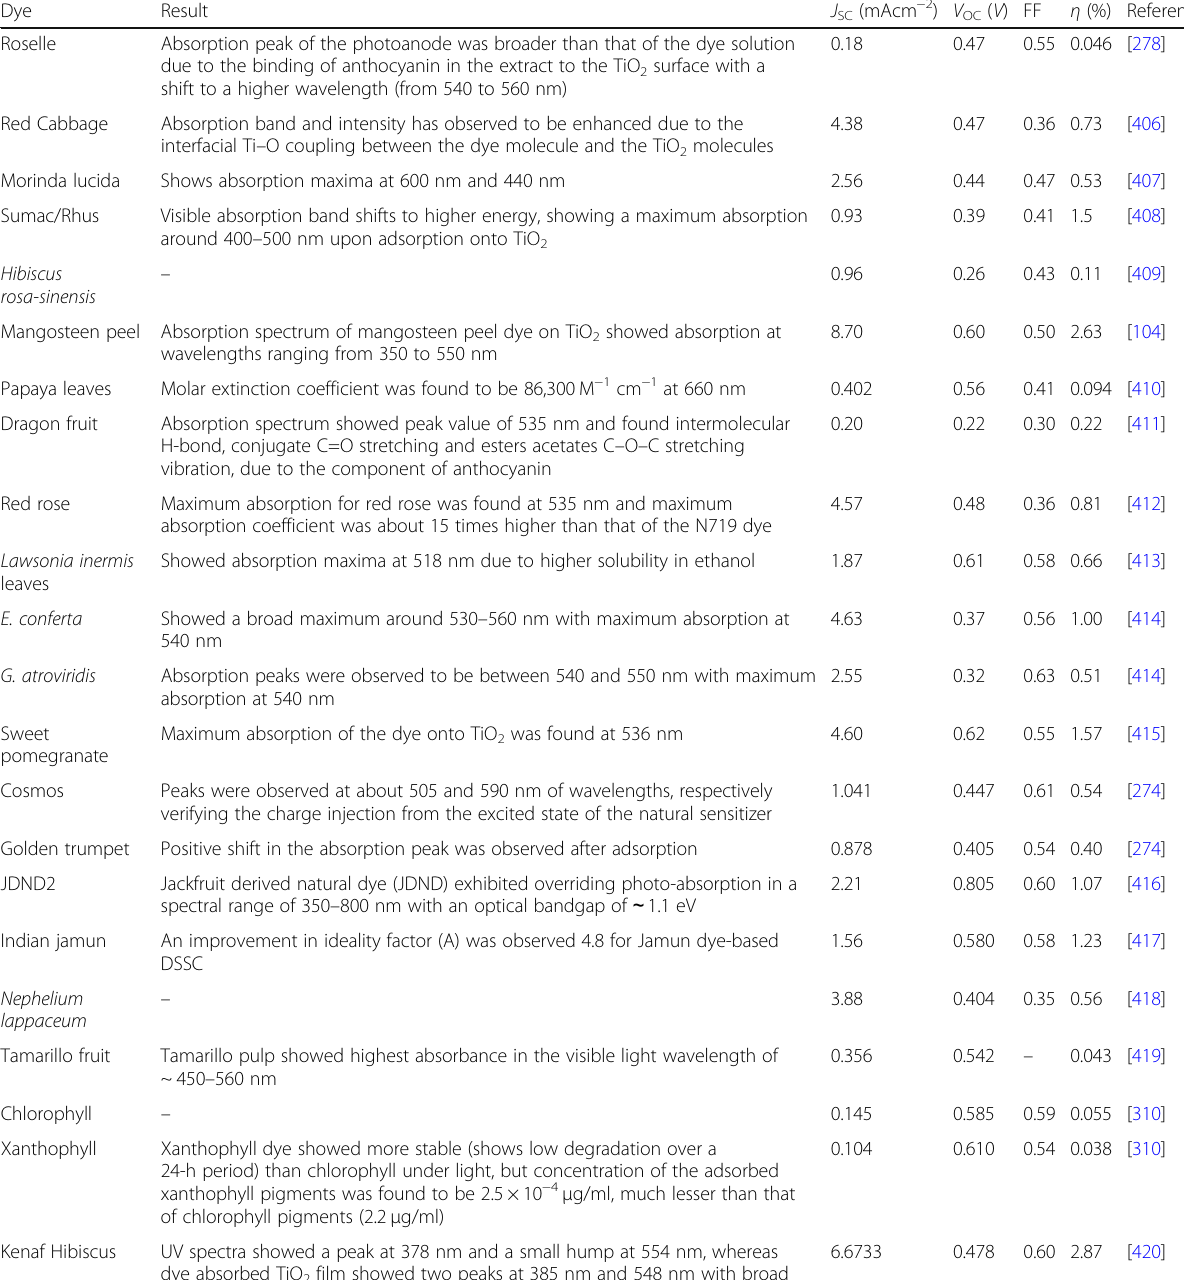
Table 6 PV characteristics for different natural dye-sensitized solar cells